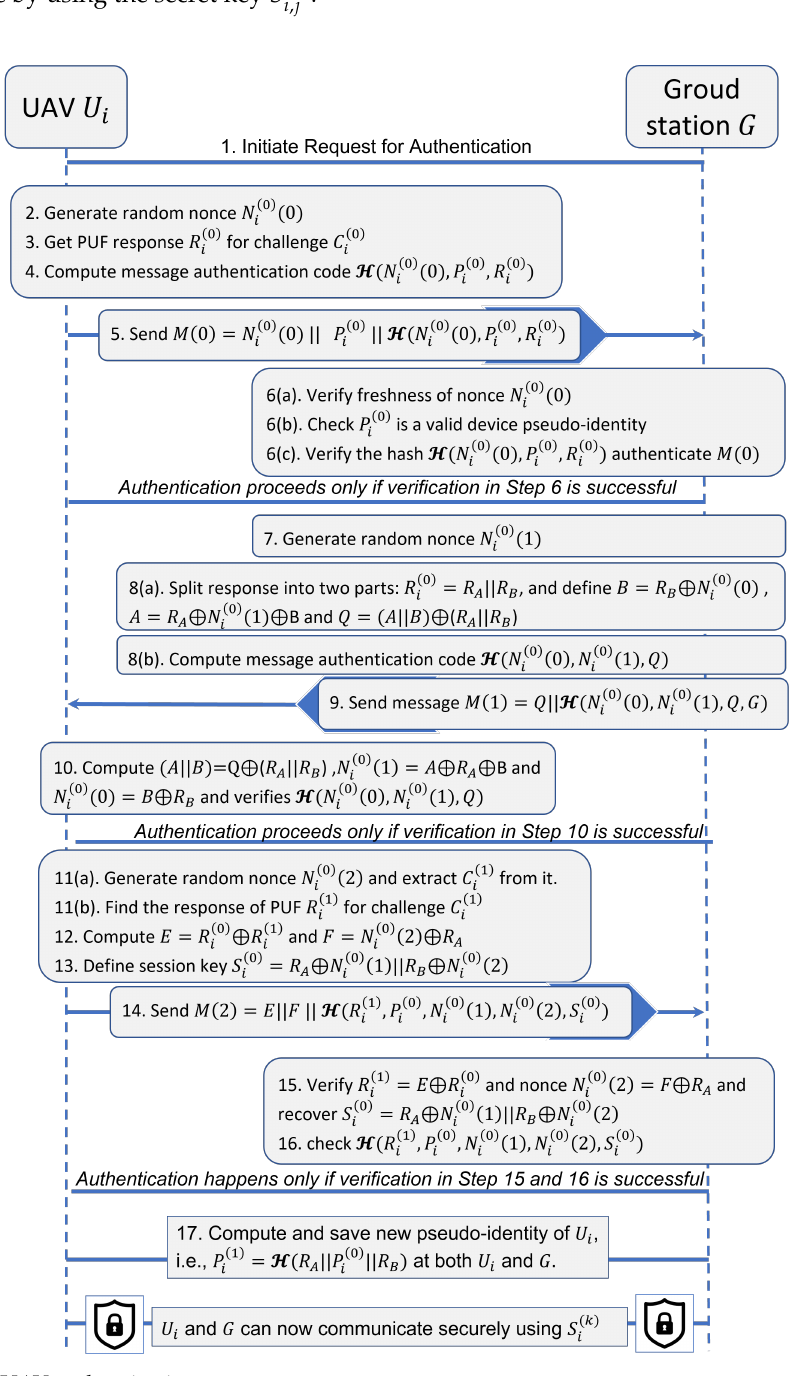
Figure 2. UAV authentication